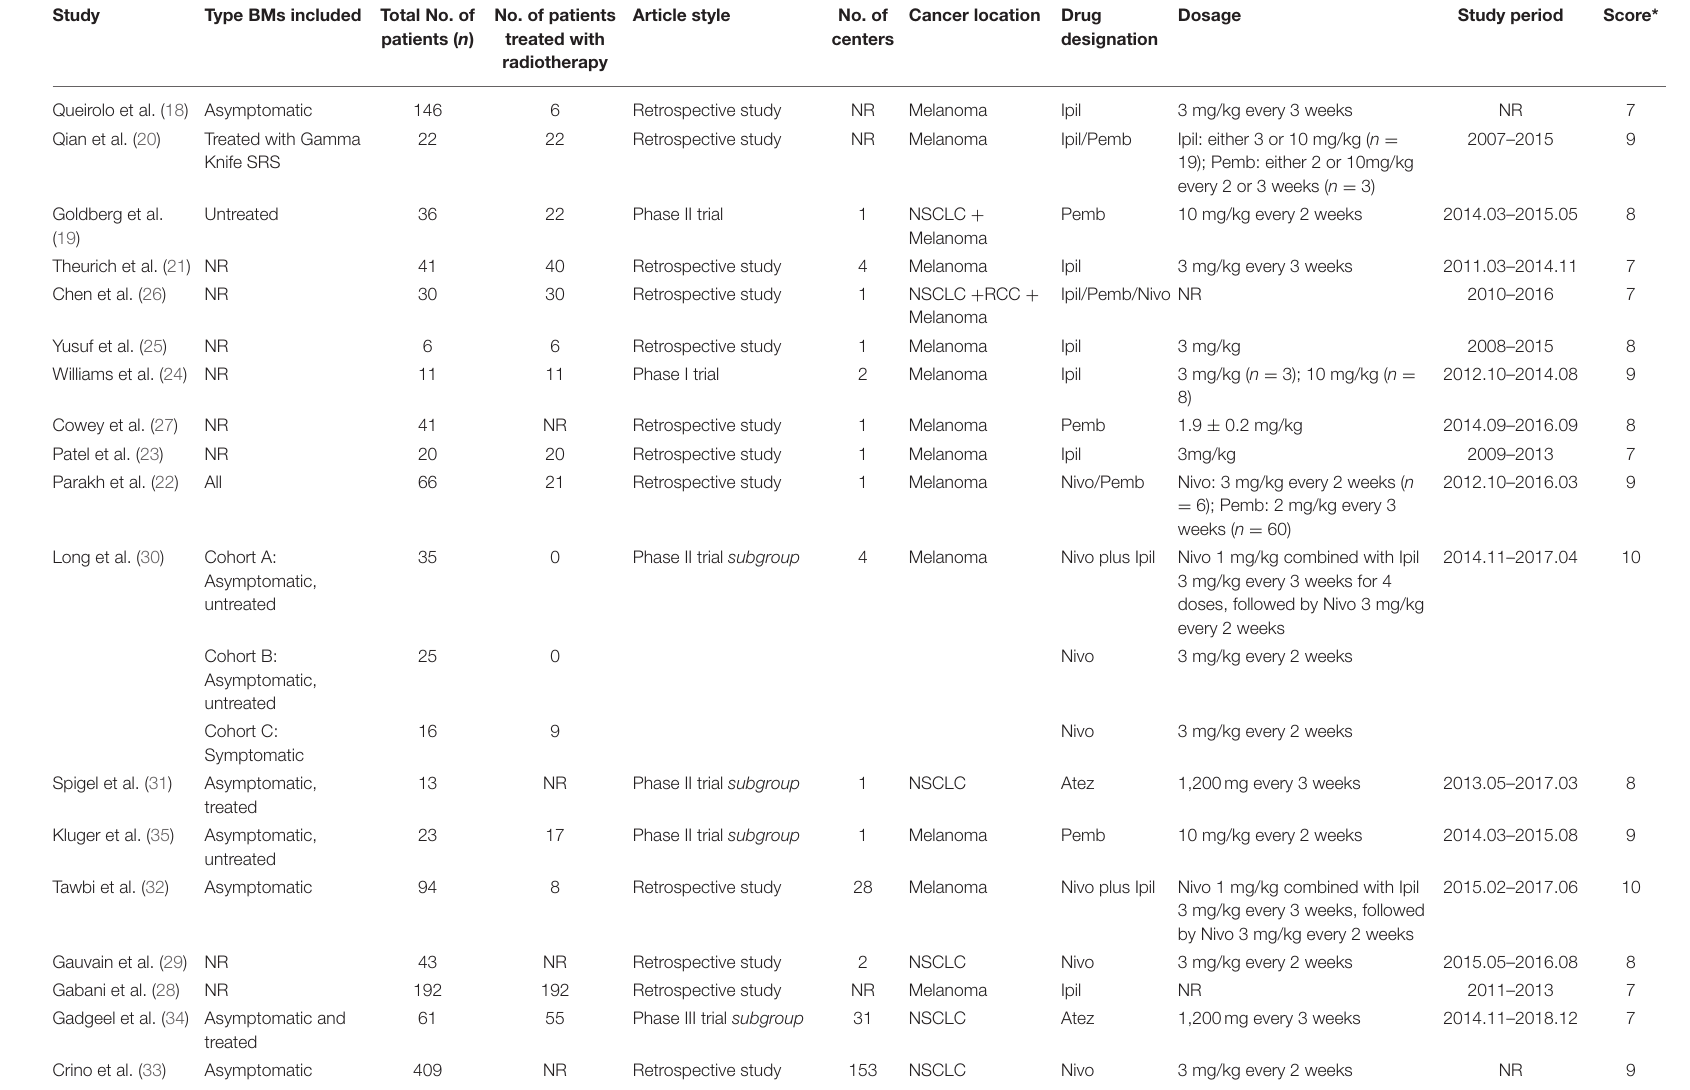
BMs, brain metastases; NSCLC, Non-small-cell lung cancer; NR, Not report; RCC, Renal Cell Carcinoma; Ipil, Ipilimumab; Nivo, Nivolumab; Pemb, Pembrolizumab; Atez, Atezolizumab. * The quality of citation was assessed according to NOS (retrospective study and phase I, II trial) and Jadad score (phase III